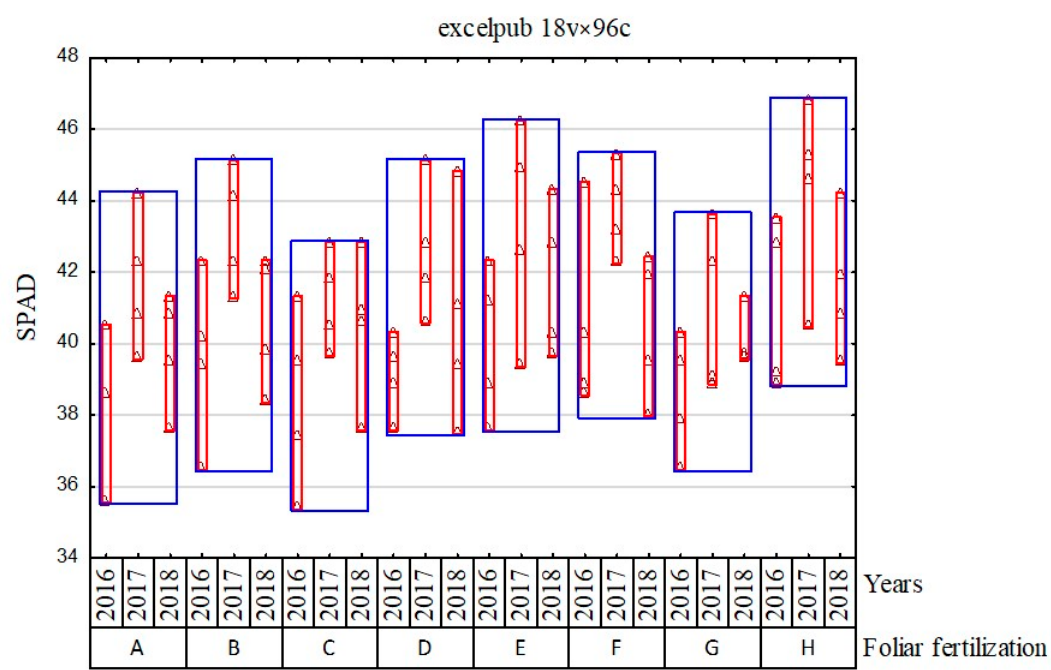
Figure 2. Soil plant analysis development (SPAD value). Description in Table 1. The LAI index was most favorably influenced by the application of a combination of three foliar fertilizers (H). The LAI index was the highest in 2018, and significantly lower in 2017, as shown in Figure 3. Waraich et al. [51,52] demonstrated the usefulness of LAI measurements in the experiments involving camelina. Together with other measurements, they allowed the demonstration of how the plant reacted to the tested factor.